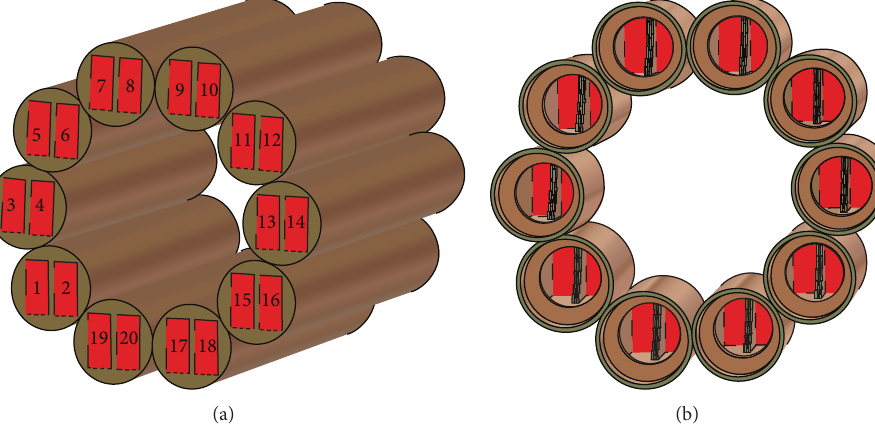
Figure 5: Geometry of the horn antenna array: (a) Back view. (b) Front